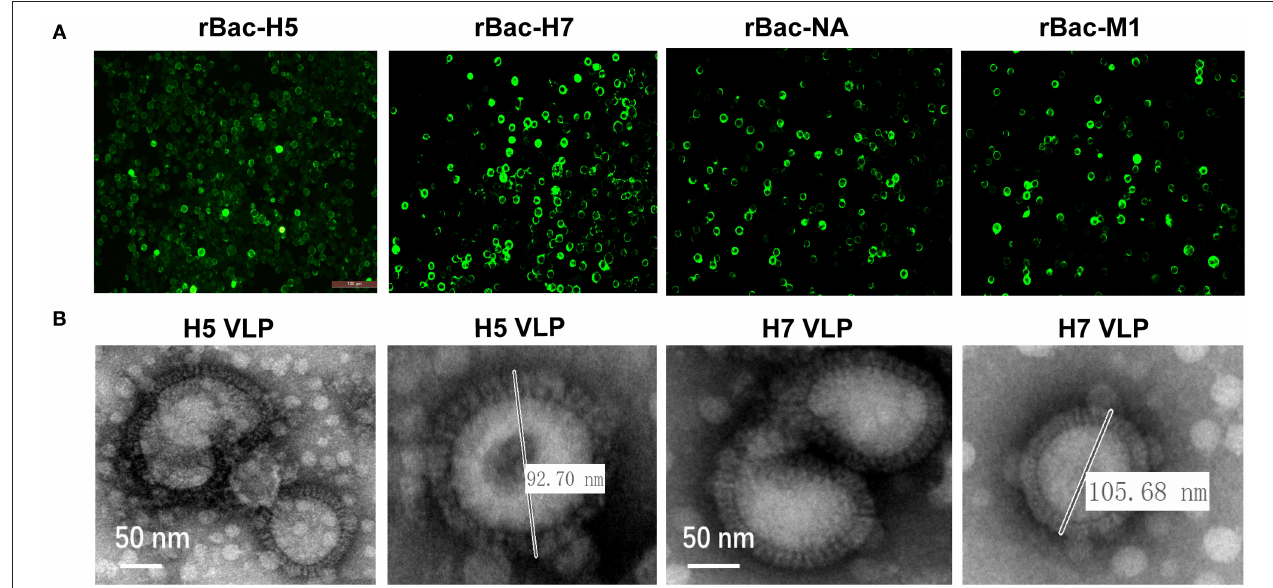
FIGURE 1 | Generation and characterization of H5 and H7 VLP. (A) Recombinant baculovirus (rBVs) rBac-H5, rBac-H7, rBac-NA, and rBac-M1 were successfully identified using immunofluorescence assay (IFA) by HA, NA, and M1-specific antibody in Sf9 cells. (B) To generate H5 VLP, Sf9 suspension cells were co-infected with rBac-H5, rBac-NA, and rBac-M1 at a MOI ratio of 1:1:1. To generate H7 VLP, Sf9 suspension cells were co-infected with rBac-H7, rBac-NA, and rBac-M1 at the same MOI ratio. At 72h p.i., cell supernatant was harvested for collection of the H5 and H7 VLP. A transmission electron microscope (EM) was used for observation of the morphology and size of the H5 and H7